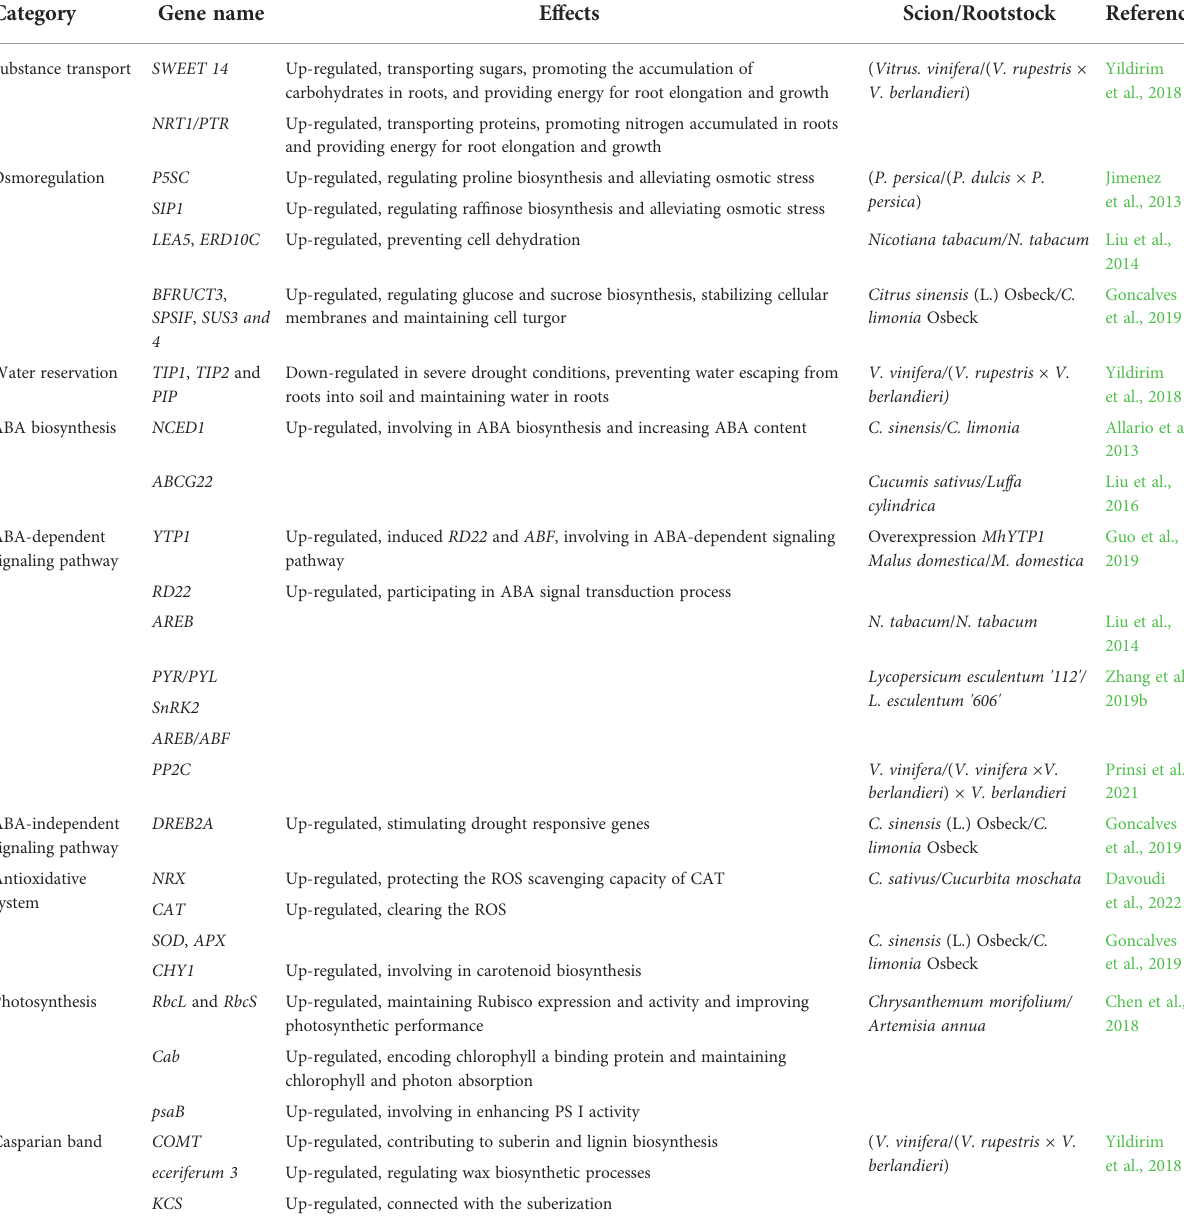
TABLE 1 Grafting in fl uences the expression of drought responsive